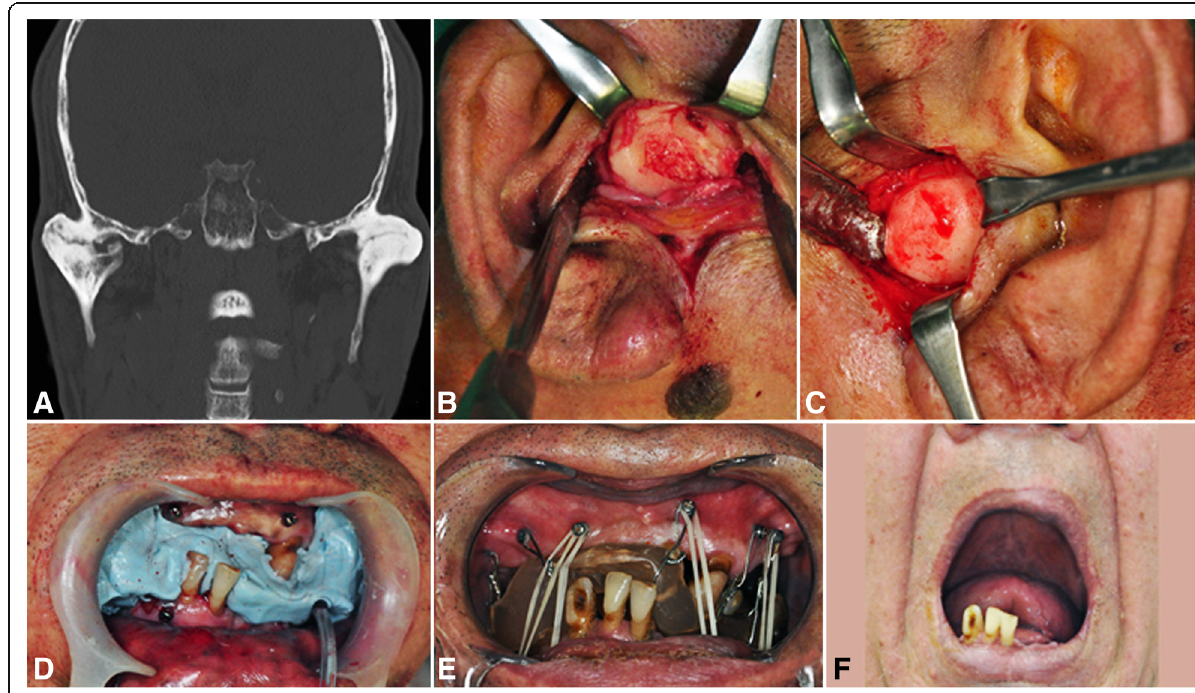
Fig. 4 A 61-year-old male, bilateral TMJ ankylosis secondary to trauma, showing coronal CT scan ( a ), endaural approaches with ankylosed mass exposure at the right ( b ) and left ( c ) condyle, intraoperative bite registration to make an interocclusal splint ( d ), interocclusal splint retained on maxillary screws ( e ), and mouth opening appearance after active mouth opening on 7 years later ( f